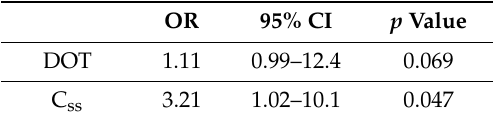
Table 5. Multivariate analysis of independent risk factors for colistin-associated nephrotoxicity at the end of